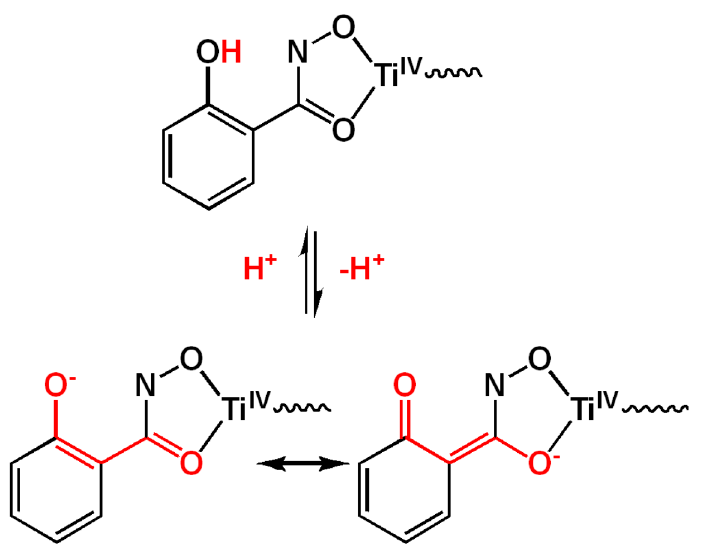
Figure 8. 2D { 1 H} grNOESY 1 + 4 equivalents of But 4 NOH + 0.1 equivalents of H 2 dihybe. Blue lines show the chemical exchange between the tetranuclear titanium complex and the free ligand. In the blue circles correspond the NOESY peaks between H( d ) and H( b ) protons of two chelating dihybe 2 − ligands (Scheme 5). H( a )–H( d ) are the protons of the ligand shown on the top of Figure 6. * The protons of the free ligand.